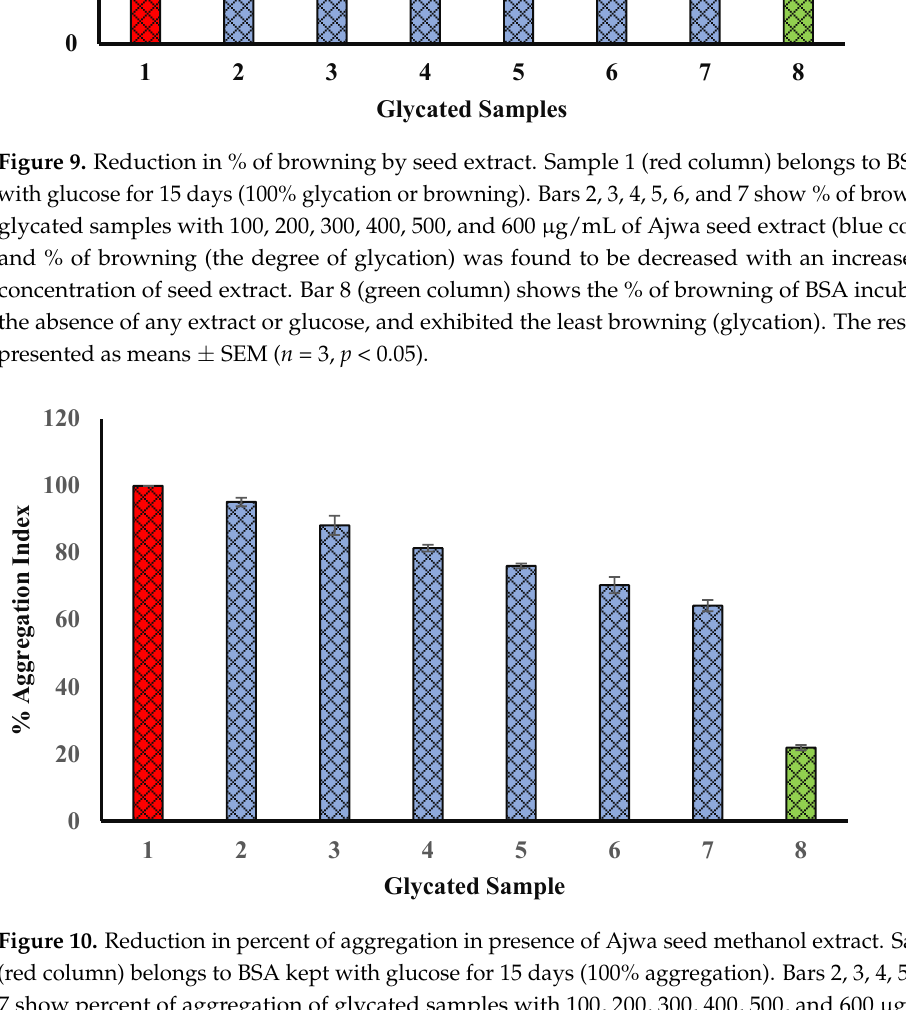
concentration of seed extract. Bar 8 (green column) shows the % of browning of BSA incubated in the absence of any extract or glucose, and exhibited the least browning (glycation). The results are presented as means ± SEM ( n = 3, p < 0.05).